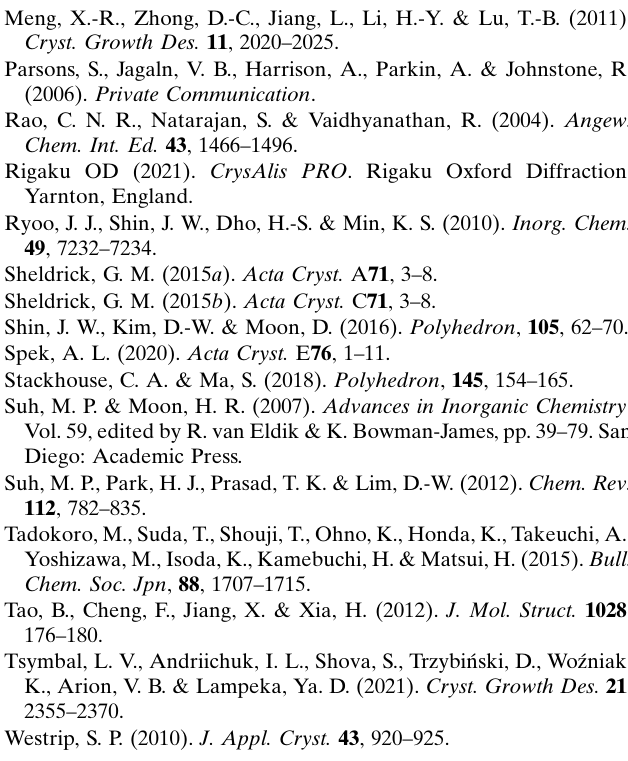
Data collection